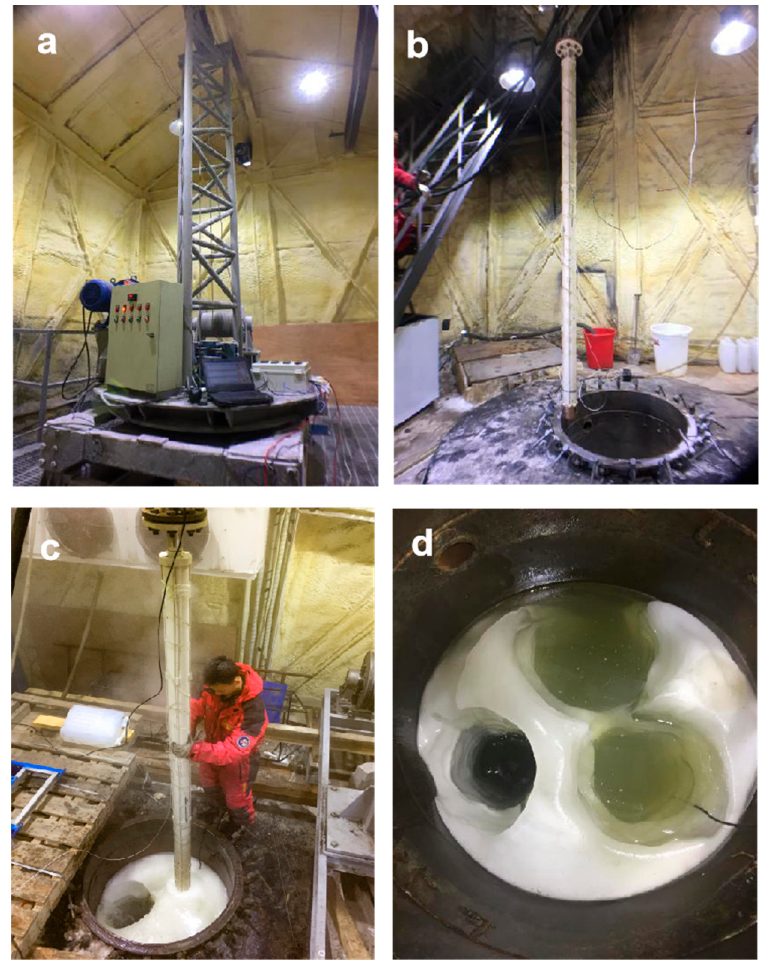
Figure 8. Pictures during testing of the hot water ice-coring drill: ( a ) control and data collecting system; ( b ) the drill suspended on the top of the ice well; ( c ) drilling; ( d ) shape of borehole after drilling. The size of the ice cores drilled and diameter of boreholes recovered were measured (Figure 9).